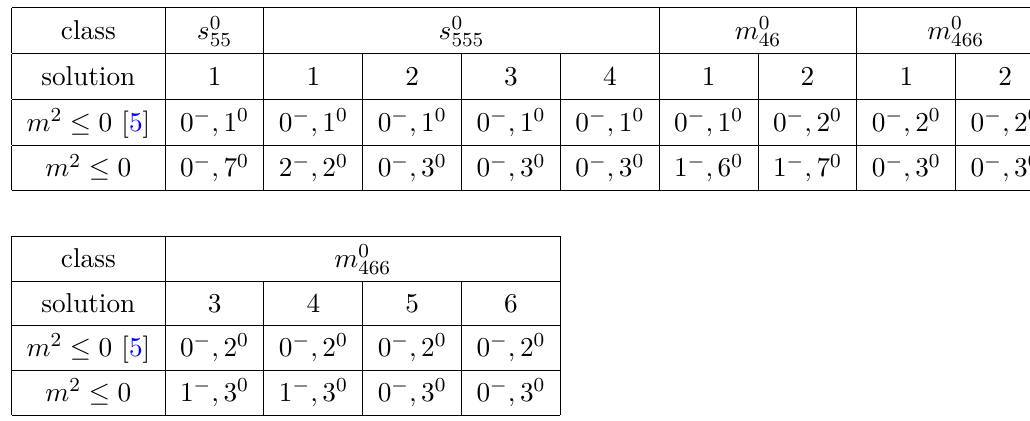
Table 8 . Spectrum information for each Minkowski solution in type IIA/B. We indicate by i − , j 0 the number j of massless modes and i of tachyons, first for the fields ( ρ, τ, σ and then for the complete set of scalar fields considered